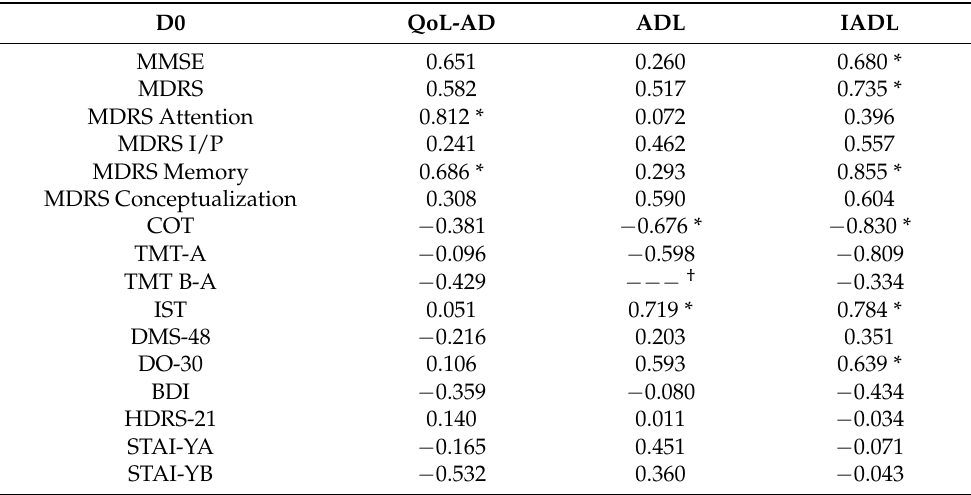
Table 2. Spearman’s Rho for baseline measures’ (D0) correlations with quality of life and func- tional ability. D0 QoL-AD ADL IADL MMSE